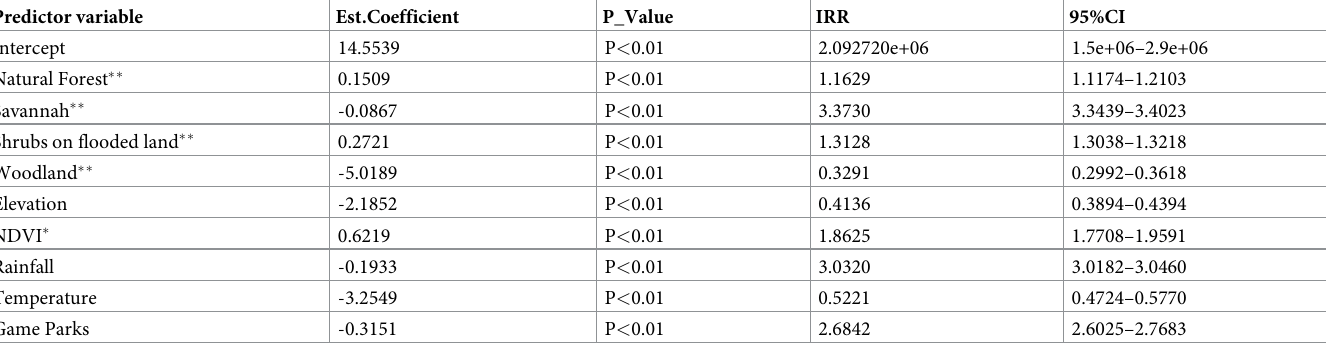
Table 2. Multivariate Poisson regression coefficients and their p -values, IRR and confidence intervals.